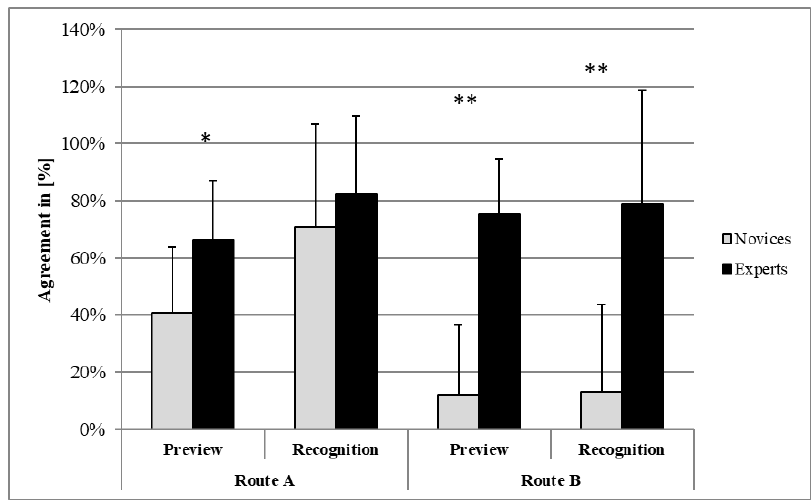
Figure 4. Percentage of agreement between the preview of the route and the climbed moves (preview) as well as the agreement of the climbed moves and the recognition of climbed moves (recognition); group differences were calculated by Mann–Whitney U test (* = p < 0.05, ** = p < 0.01).